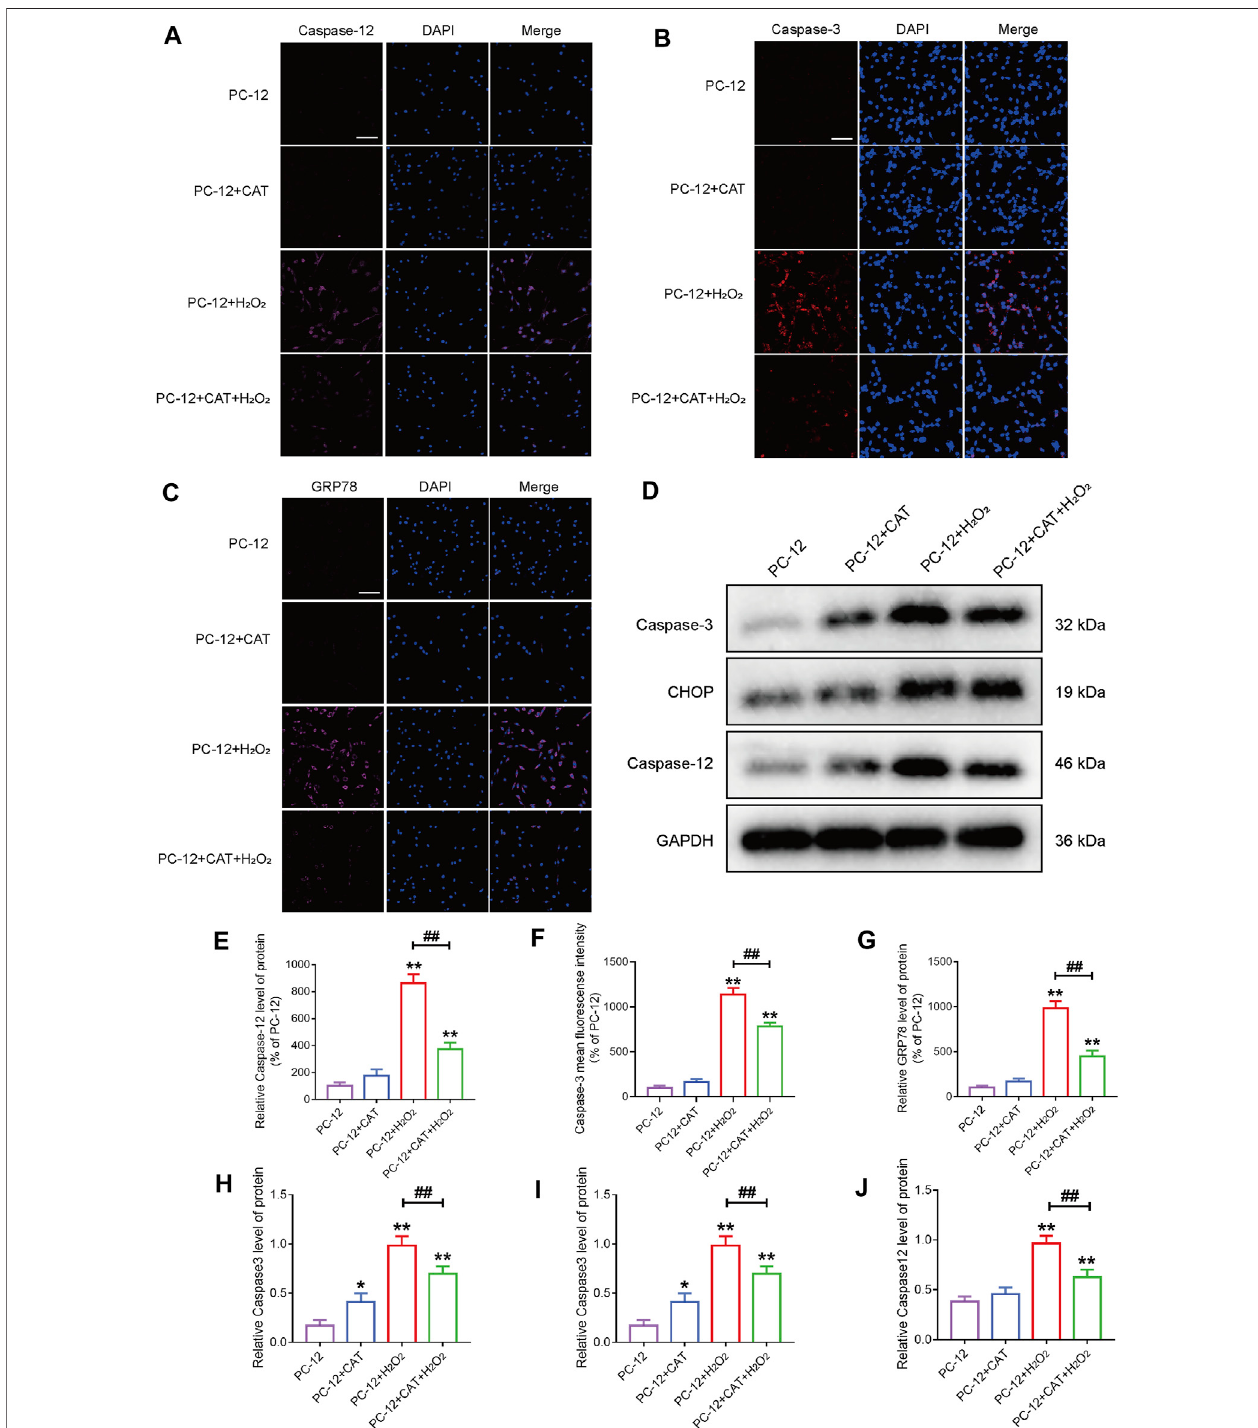
FIGURE 8 | CAT reduces the damage of hydrogen peroxide to PC-12 cells. (A – C) Immuno fl uorescence staining of Caspase-3 (bright red), Caspase-12 (bright pink), andGRP78(brightpink), inthePC-12 group, PC-12 + CAT group, PC-12 + H 2 O 2 group, andPC-12 + CAT + H 2 O 2 group. Thenucleiare labeled byDAPI(blue), and magni fi cation is ×40. (D) Western blotting analysis showing protein expressions of Caspase-3, CHOP, and Caspase-12. (E – G) Caspase-3, Caspase-12, and GRP78 fl uorescenceintensity(%ofPC-12). (H – J) QuantitativeanalysisoftheproteinexpressionofCaspase-3,CHOP,andCaspase-12.Student ’ sttestwasused to analyze immuno fl uorescence staining and Western blotting results. “ * ” represents p < 0.05, “ ** ” represents p < 0.01 versus the PC-12 group. “ ## ” represents p < 0.01 comparing the PC-12 + H 2 O 2 group to the PC-12 + H 2 O 2 + CAT group with statistical signi fi cance. Data are represented as mean ± SD ( n = 3).